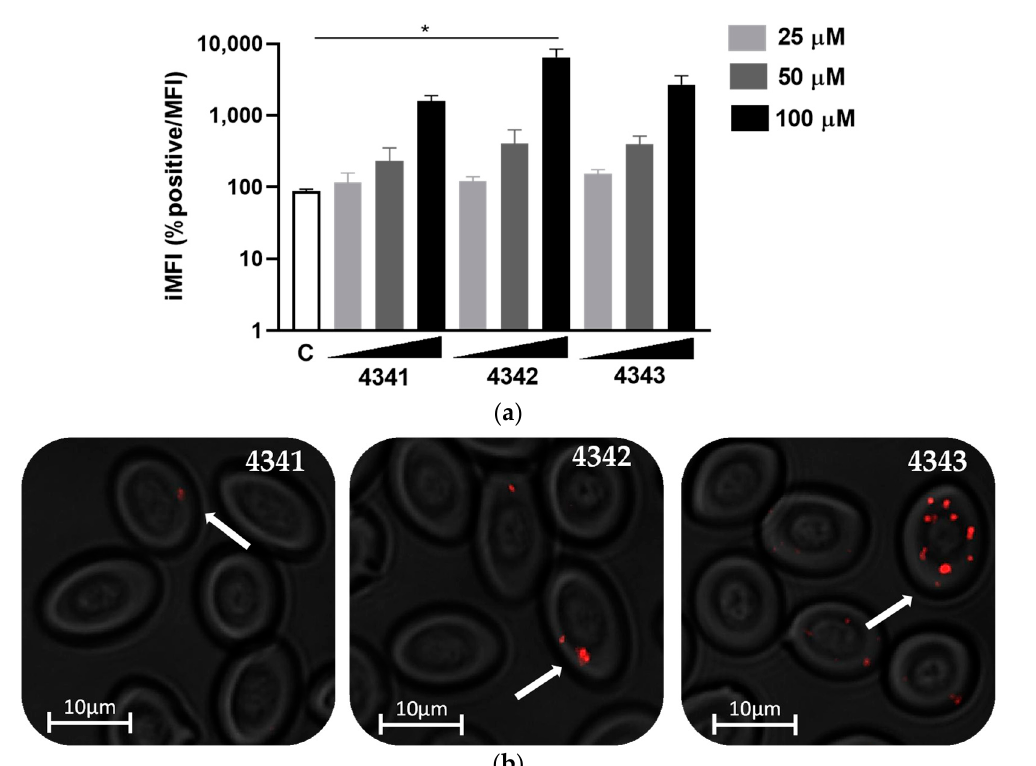
Figure 1. Peptide binding to rainbow trout RBCs in vitro, evaluated by means of flow cytometry. ( a ) Integrated median fluorescence intensity (iMFI) (% positive cells × MFI) of rainbow trout RBCs treated with different peptide concentrations, 90 min after incubation, analyzed by flow cytometry. Data represent the mean ± standard deviation (SD), n = 3. Kruskal–Wallis test with Dunn’s multiple comparison test was performed (* p < 0.05). C means untreated control RBCs. ( b ) Representative images of rainbow trout RBCs treated with the three selected peptides, 90 min after incubation, with 100 µM of each peptide. Images were taken with the IN Cell Analyzer 6000 Cell Imaging system at 40× magnification. Peptides are labeled with Rhd B (red). White arrows indicate peptide binding to RBCs.